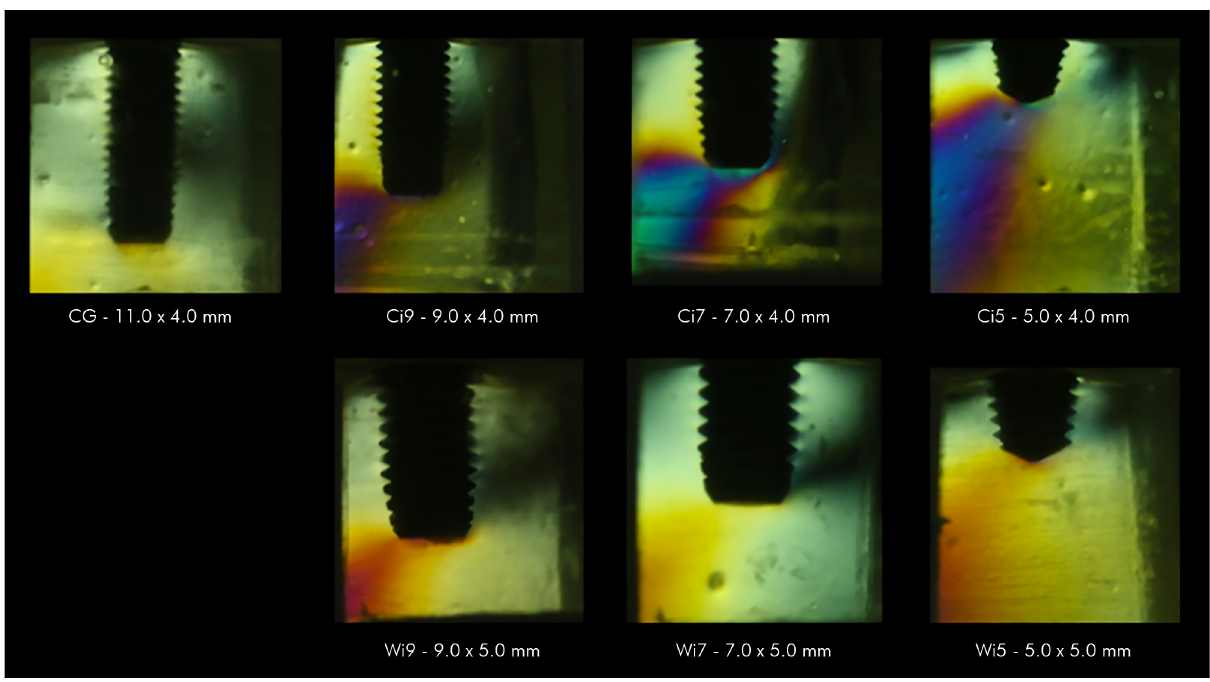
Figure 6. Illustration of the behaviour of fringes in the groups to implant